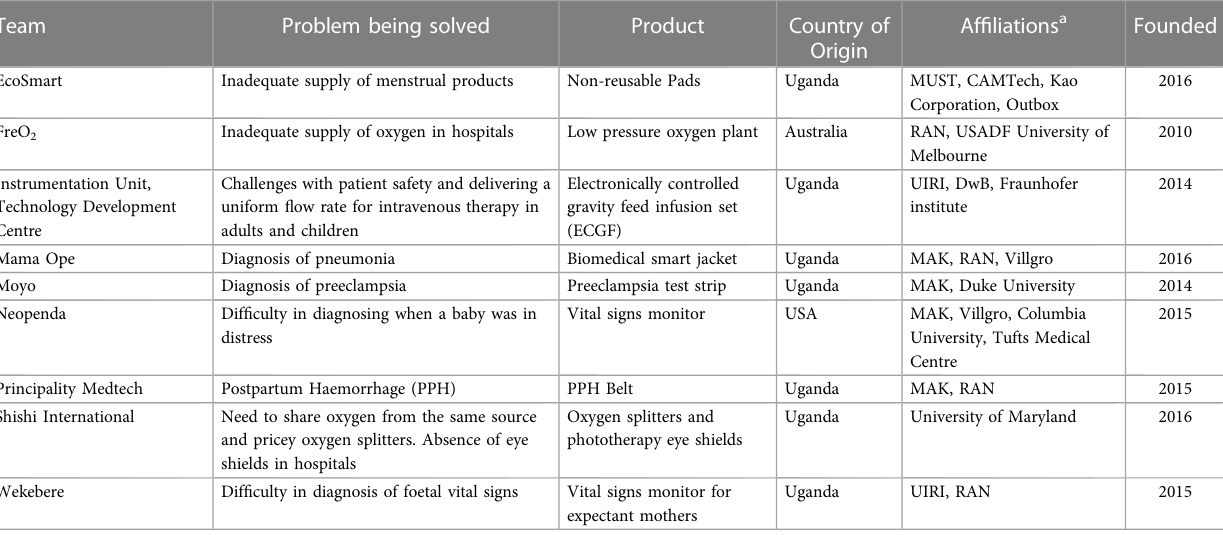
TABLE 1 Description of the medical device